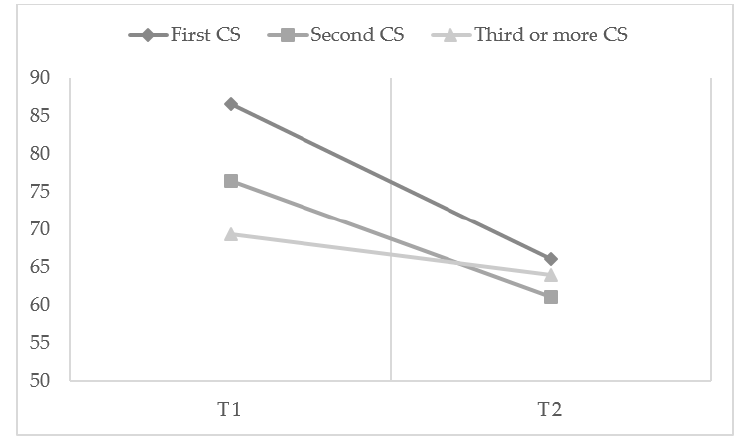
Figure 3. Time trend of EQ-VAS scores in cesarean section (CS) groups.